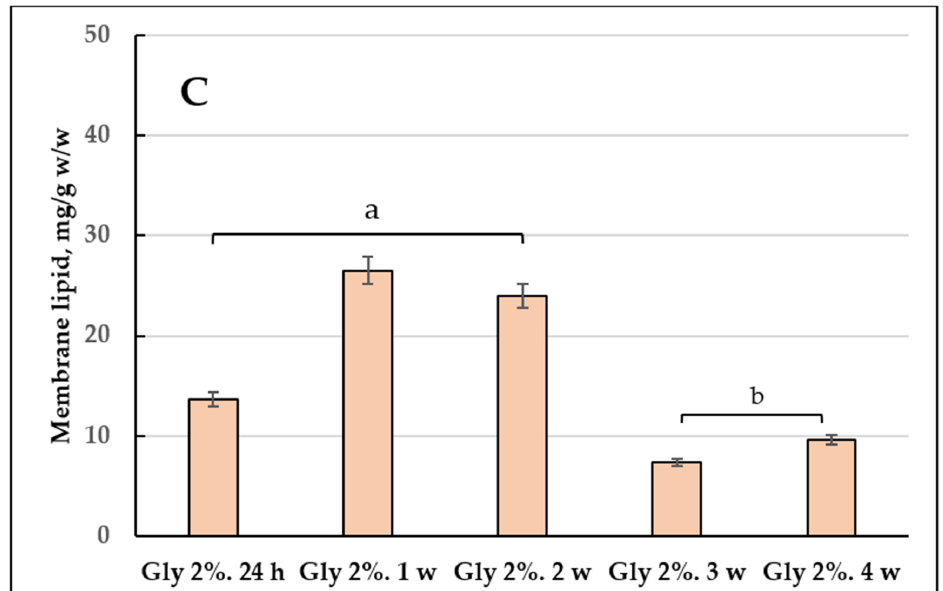
Figure 4. The membrane lipid composition in the E.magnusii yeast grown on the different substrates. The share of each storage lipid fraction, %; ( A ) glucose 0.5%; ( B ) glucose 2%; ( C ) glycerol 2%. Error bars represent the standard deviation of triplicates. Mean values are displayed (n = 3, ±SD). a— p < 0.04; b— p < 0.01; c—did not differ significantly.